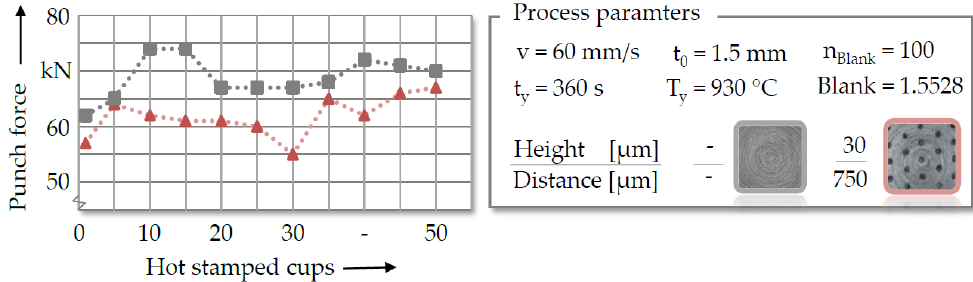
Figure 18. Maximum punch force value of every fifth manufactured cup by using a locally modified as well as a conventional die.